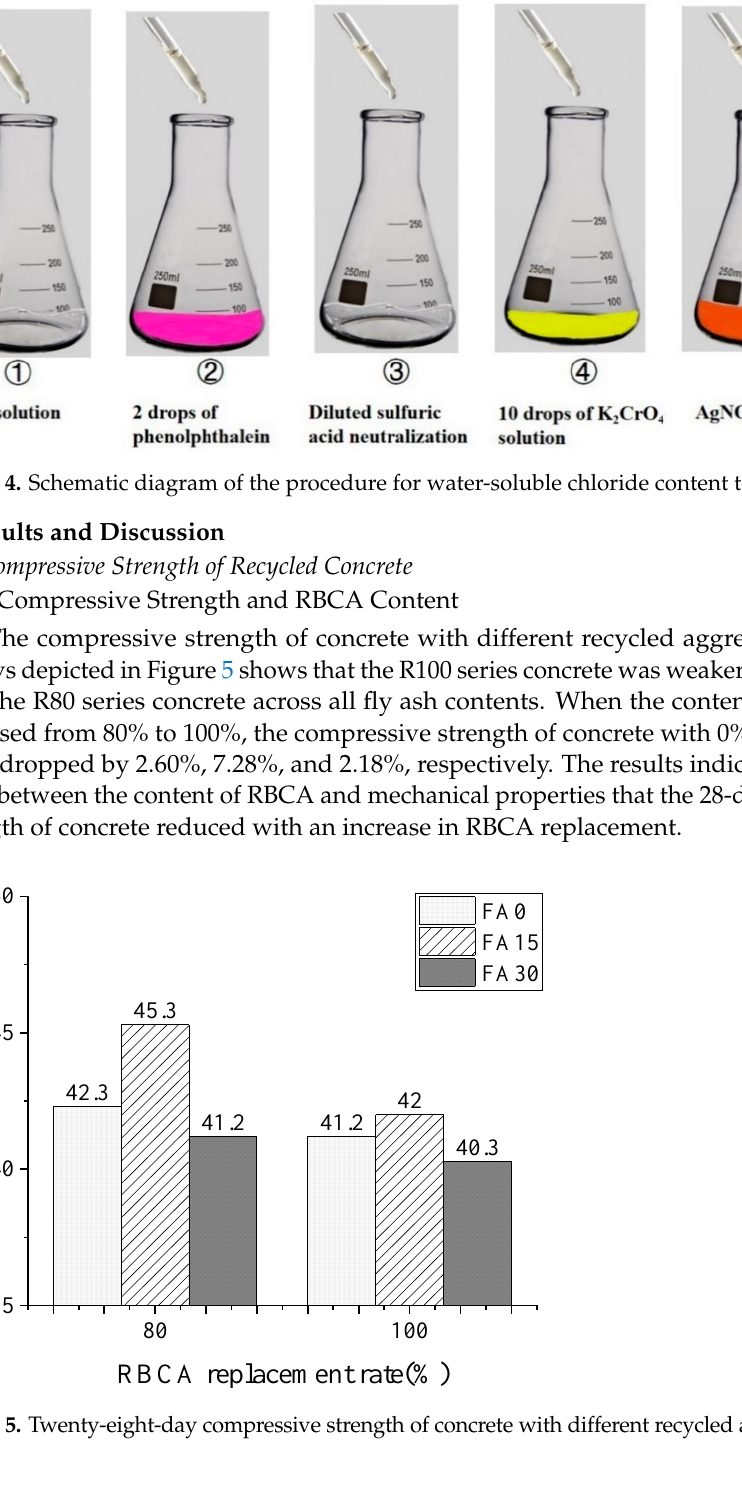
Figure 4. Schematic diagram of the procedure for water-soluble chloride content test.